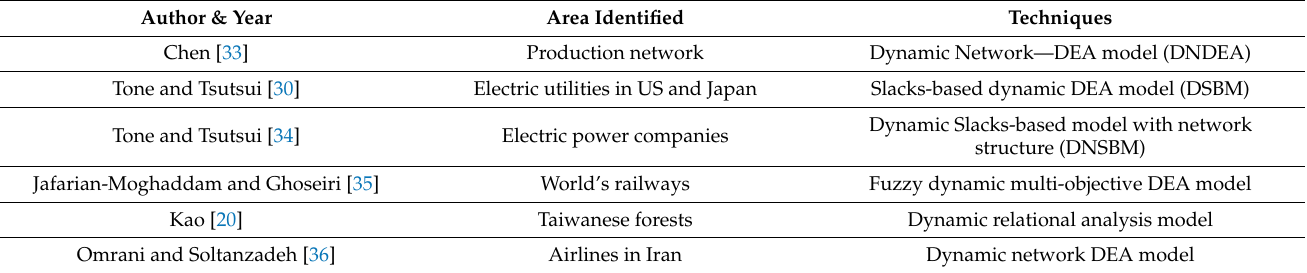
Table 2. Methods for the evaluation of R&D performance under the dynamic DEA